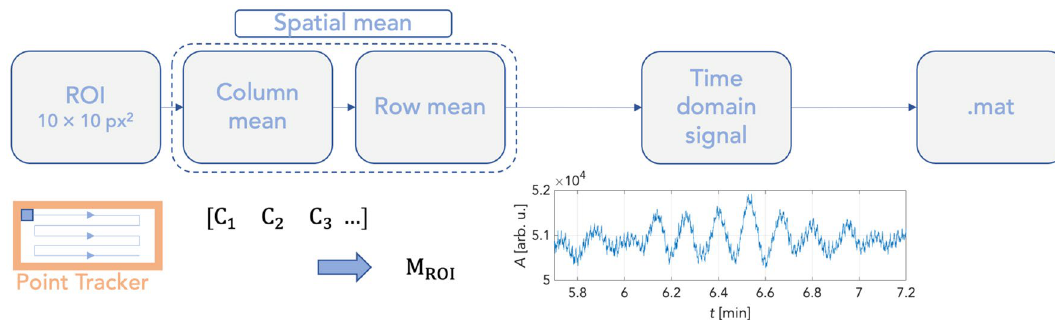
Figure 4. Process of obtaining PPG signals in time